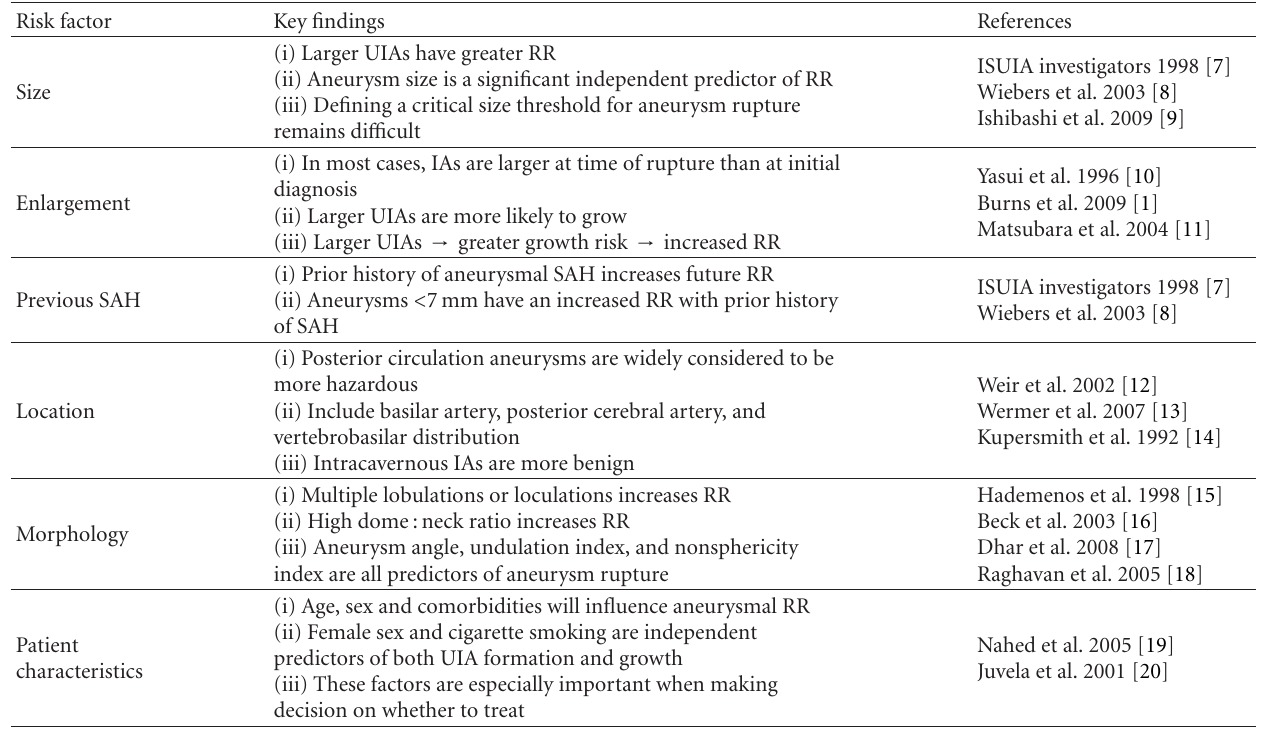
Table 1: Key findings related to the natural history